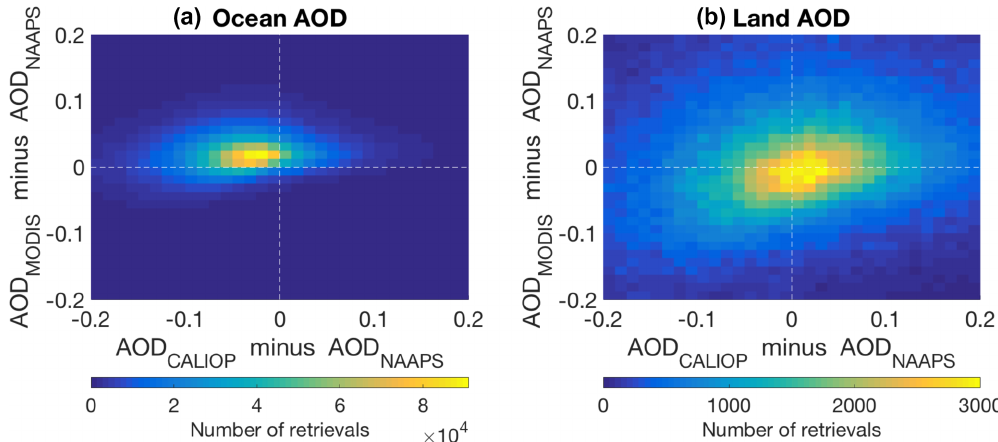
Figure 4. 2-D histogram of AOD innovations for ocean retrievals (a) and land retrievals (b) over SEA during 2006–2016. AOD CALIOP minus AOD NAAPS is shown on the x axis and AOD MODIS minus AOD NAAPS is shown on the y axis. The color scale represents the count of retrievals in each bias bin. Only cloud-cleared pixels classified by both MODIS and CALIOP are included. Only pixels where NAAPS, MODIS, and CALIOP all detect non-zero AOD are